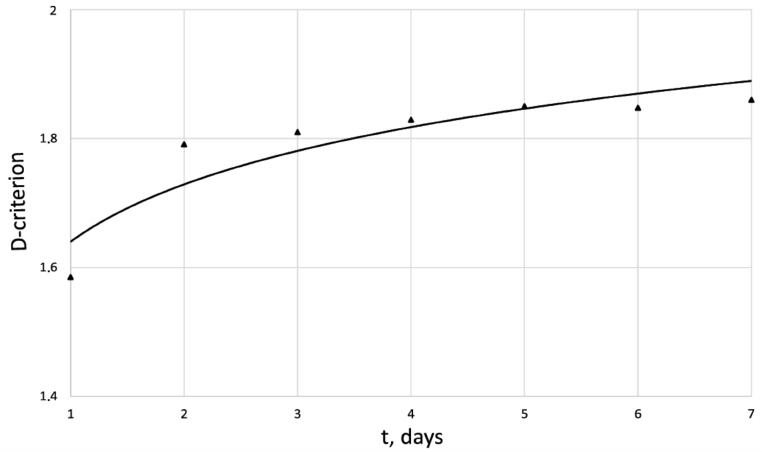
Figure 6. Dynamics of D -criterion of the human dermal fibroblasts in the control series.